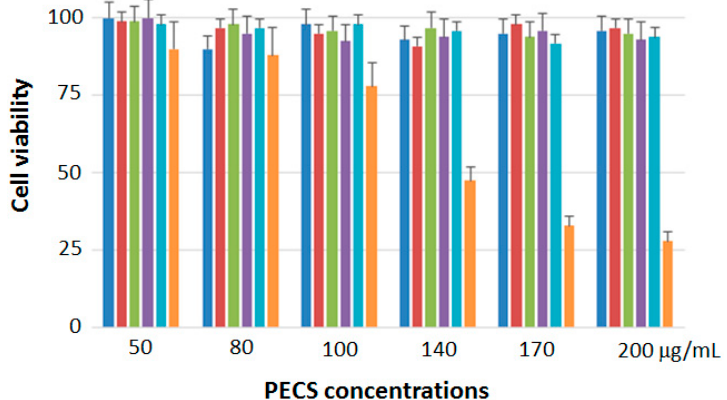
Table 1. Apoptosis studies. The percentages of live, total apoptotic, and dead cells are reported for HepG2 cells before and after treatment with 137 μ g/mL of PECS at 48 h. Figure 3. Cell viability related to six cell lines, A375 (in blue), H460 (in red), MCF7 (in green), HT29 (in violet), HaCaT (in cyan), and HepG2 (in orange), after the treatment with the phenolic extract (PECS) for 48 h.